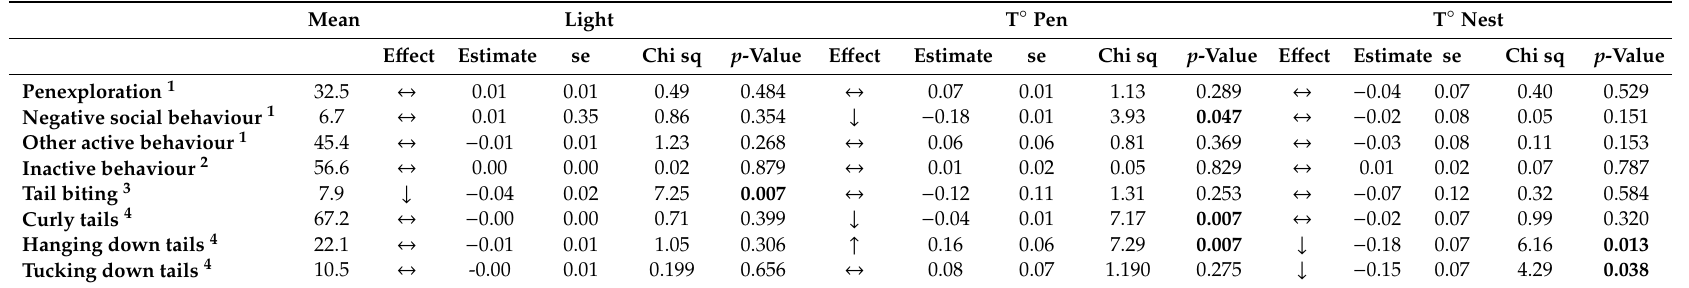
Table 3. E ff ect of light, pen temperature, nest temperature, on the observed behaviour in suckling